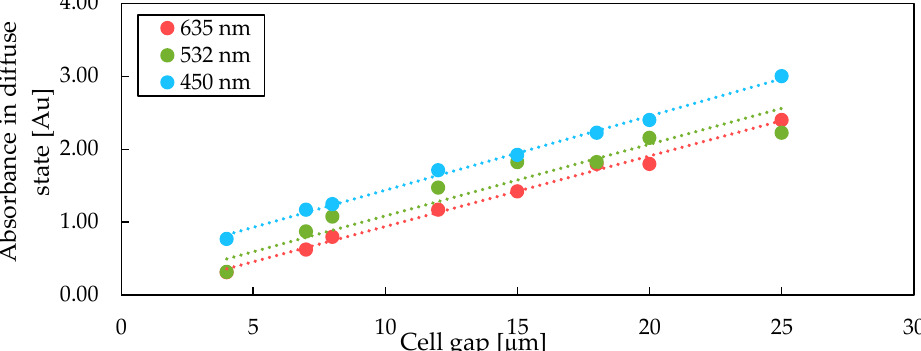
Figure 18. Change in absorbance with cell gap size of a diffuser in the scattering state for different wavelengths. The scattering for 532 nm signal is due to the quality of laser source. It is easy to notice that the absorbance depends on the wavelength of light used. For accurate color representation, a diffuser element, in an ideal case, should absorb (as well as scatter) all wavelengths in the visible spectrum equally. As can be seen from the transmission spectra in the figure below (Figure 19), this is not the case—the diffuser elements are more transparent to longer wavelengths of visible light, in both the H and FC states. This means that some color adjustments are required when rendering an image if accurate color representation is needed, as the images can otherwise have a red tint.